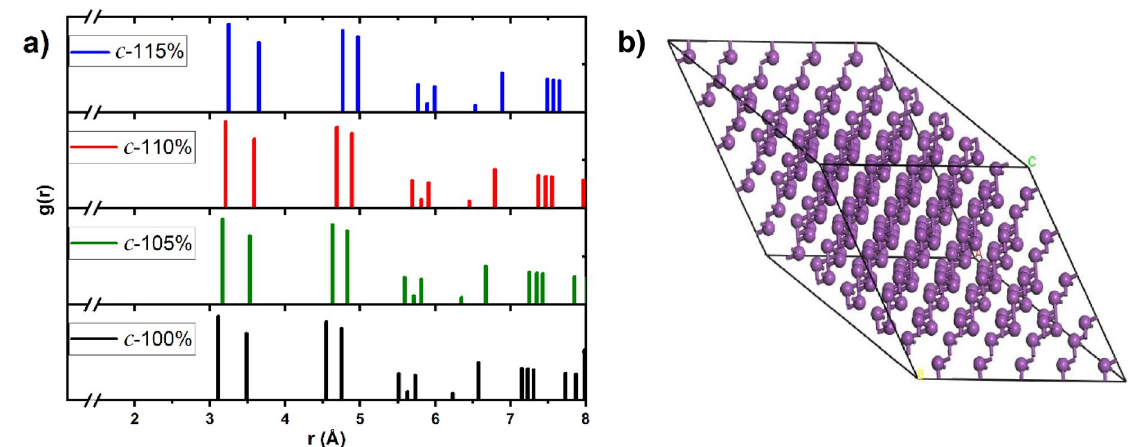
Figure 1. ( a ) PDFs for the crystalline supercell structures. The positions of the peaks undergo a displacement consistent with the expansion forced on the structures. ( b ) 250-atom supercell of the Wyckoff structure where the bilayers can be seen. Linked atoms are nearest neighbors. (Fig. 1b was obtained using the Dassault Systèmes BIOVIA Materials Studio software, version 2016-1 17 , https:// www. 3ds. com/ produ cts- servi ces/ biovia/ produ cts/